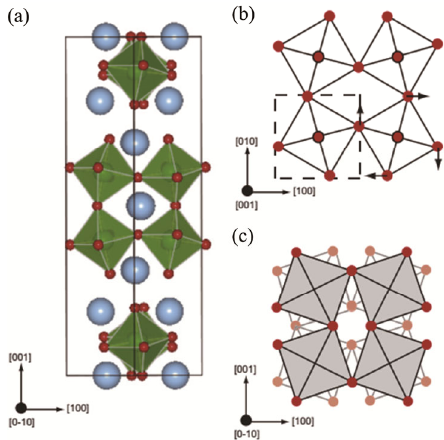
Fig. 6 (a) The (cid:1827)2 (cid:2869) (cid:1853)(cid:1865) ferroelectric ground state structure of Ca (cid:2871) Ti (cid:2870) O (cid:2875) and Ca (cid:2871) Mn (cid:2870) O (cid:2875) . Large (blue) spheres correspond to Ca ions. (b) Schematic of the atomic displacements corresponding to the X (cid:2870)(cid:2878) rotation mode. The dashed square denotes the unit cell of the (cid:1835)4/(cid:1865)(cid:1865)(cid:1865) reference structure. (c) Schematic of the X (cid:2871)(cid:2879) rotation mode. All axes refer to the coordinate system of the I 4/ mmm reference structure. Reproduced with permission from Ref. [144], © Elsevier Inc. 2012.